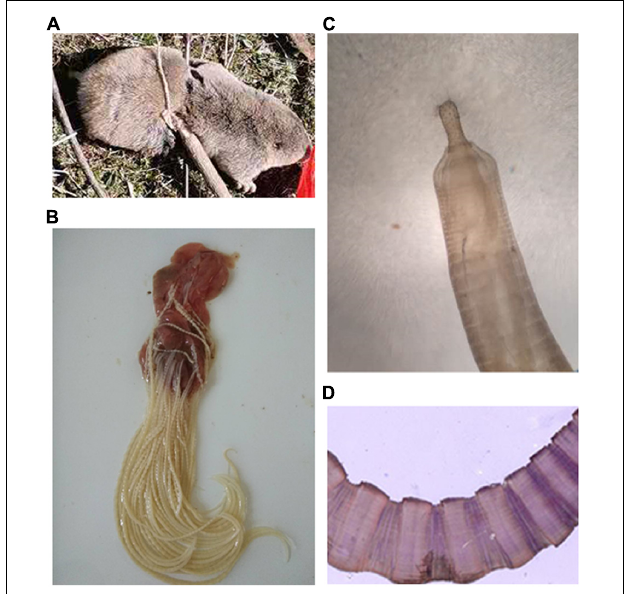
FIGURE 1 | Morphological characteristics of the hosts and Moniliformis sp. XH-2020. (A) The captured plateau zokor. (B) Parasite adsorbed in the small intestinal wall after repeated washes with PBS buffer. (C,D) The structure of proboscis and segments of the parasite as seen under a light microscope (100 ×